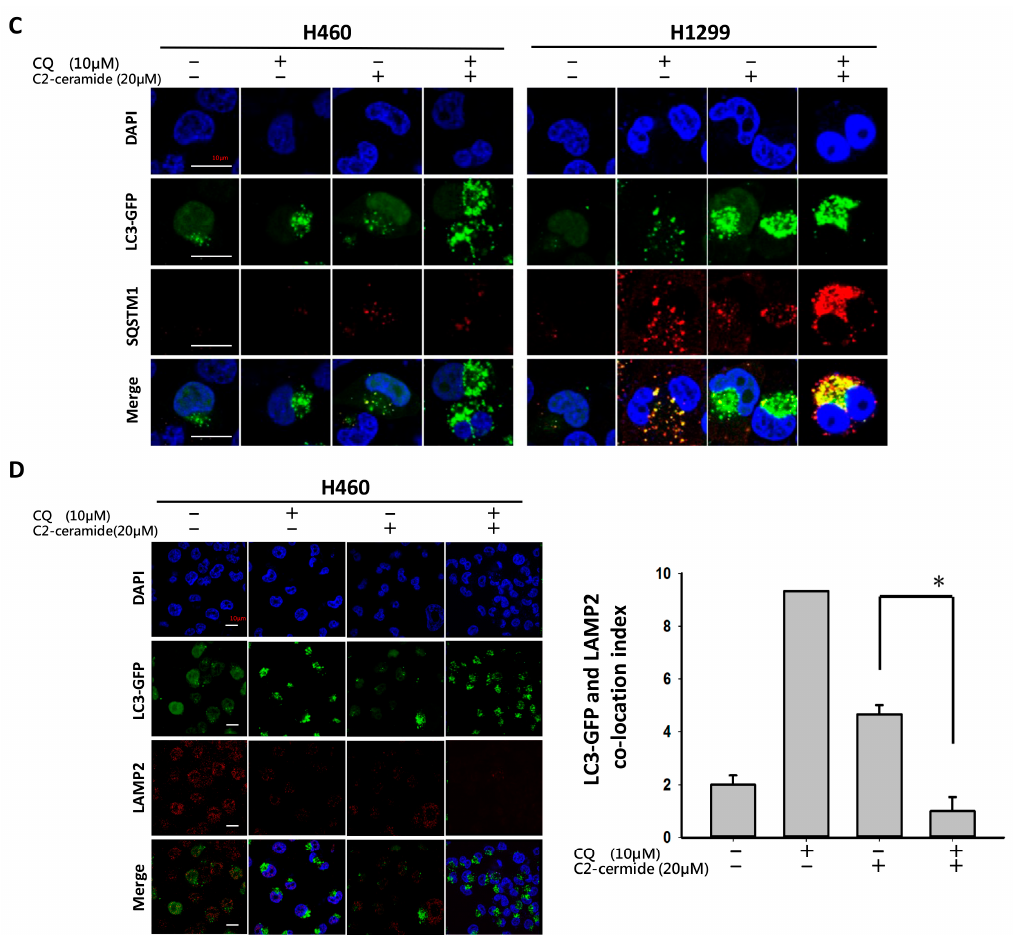
Figure 4. Enhancement of autophagy induced by combined treatment with C 2 -ceramide and CQ in NSCLC cells. ( A ) AO staining of H460 and H1299 cells for autophagy investigation. Cells were treated with the indicated concentrations of C 2 -ceramide and CQ for 24 h. Bright field (BF) for cell morphology; red for AO-positive autophagic cells. ( B ) Immunofluorescence staining of LC3 expression following combined treatment with C 2 -ceramide and CQ in H460 and H1299 cells. ( C ) Immunofluorescence staining of LC3-GFP (green) and P62/SQSTM1 (red) double staining in H460 and H1299 cells treated with C 2 -ceramide and CQ either alone or in combination for 24 h. ( D ) Immunofluorescence staining of LC3-GFP (green) and LAMP2 (red) double staining in H460 cells following treatment with C 2 -ceramide and CQ either alone or in combination. Right panel: quantification of the colocalization index. * p < 0.05.